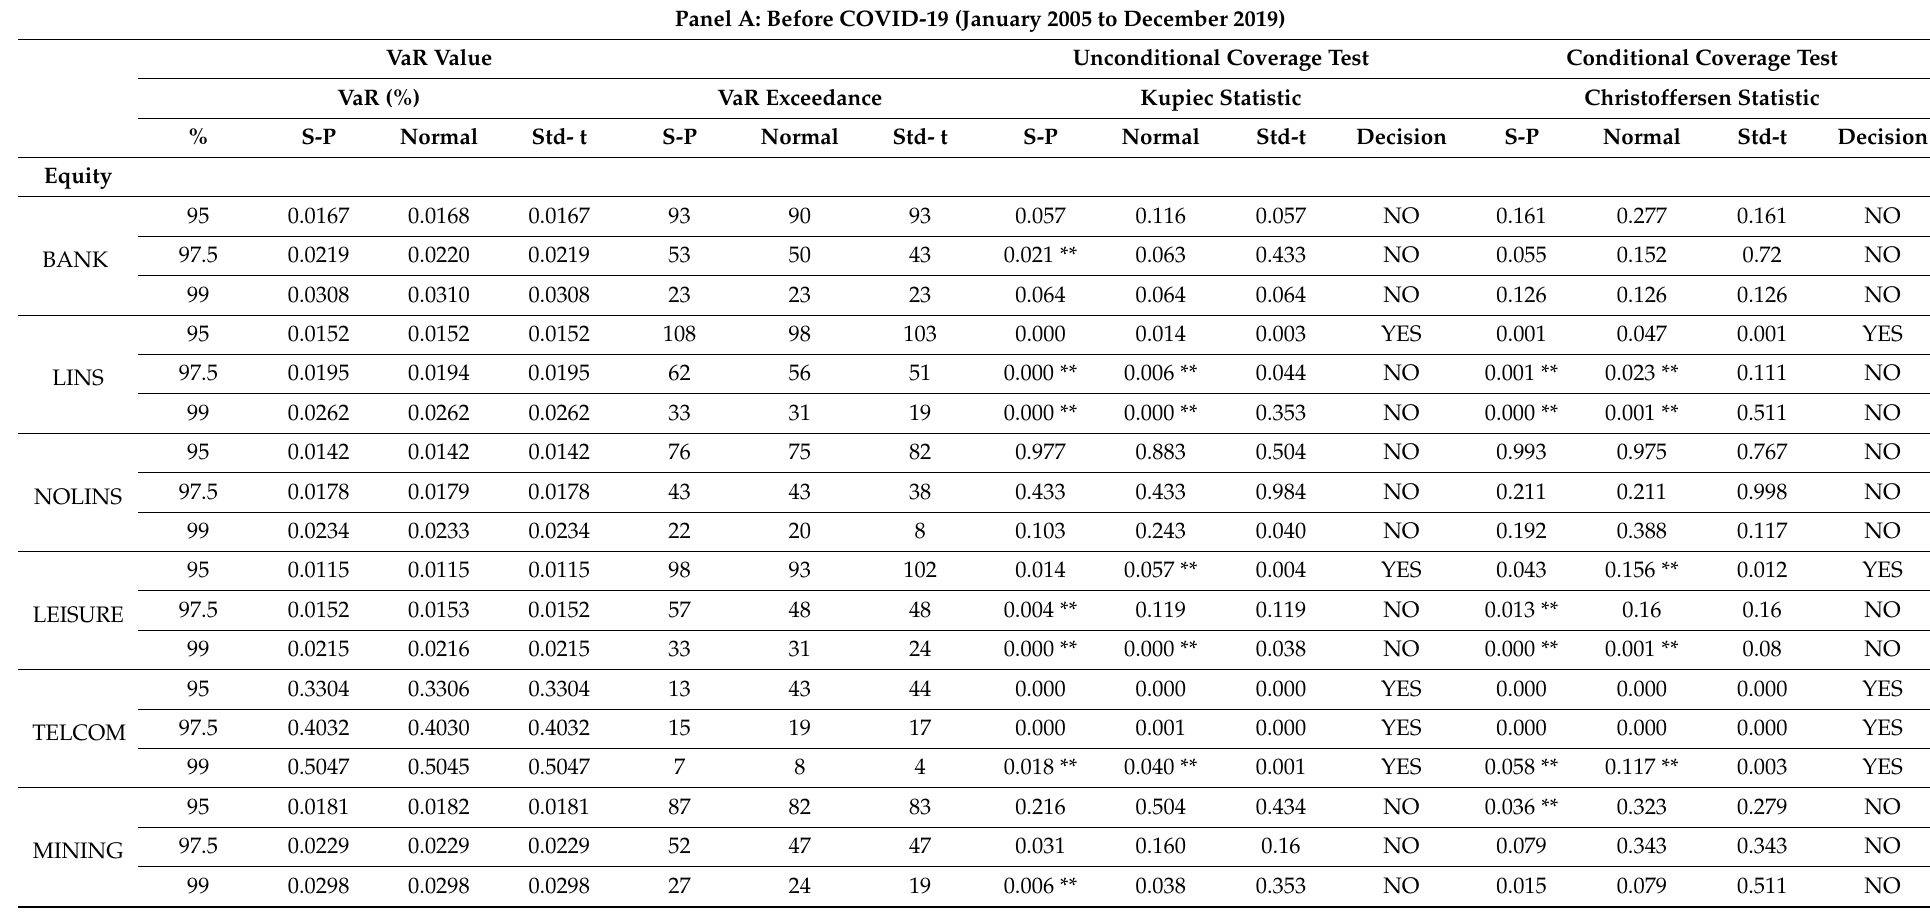
Table 4. Assessment of the dynamic properties of the marginal distribution-VaR-backtesting rolling window 1-day